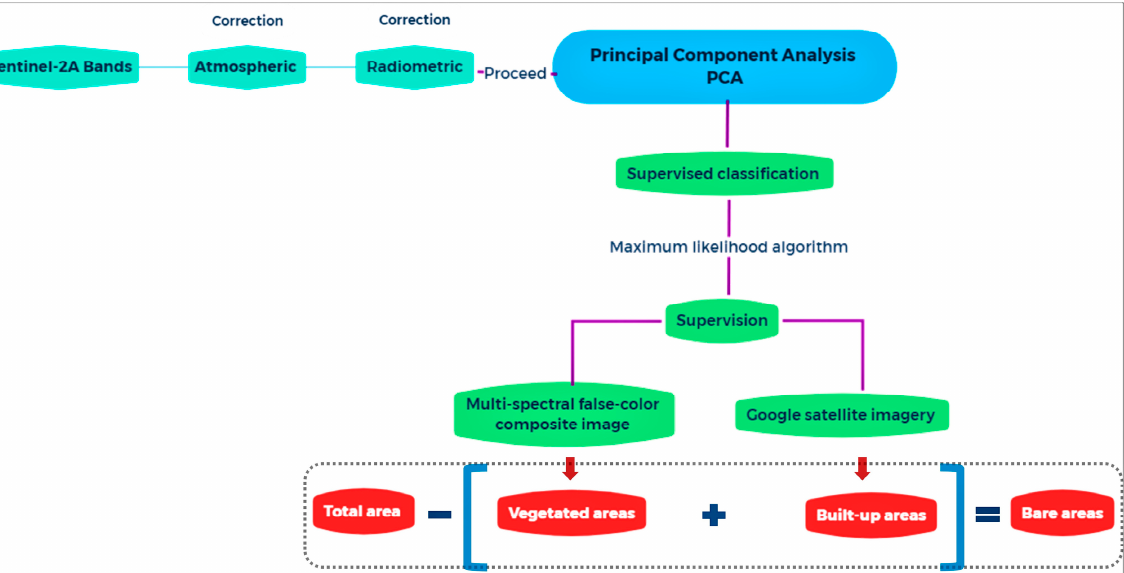
Figure 2. Methodology for the determination of the vegetation cover, built-up areas and bare areas. The third step concentrated on the calculation of the spatial distribution of LST (land surface temperature) and NDVI (Normalized Difference Vegetation Index).